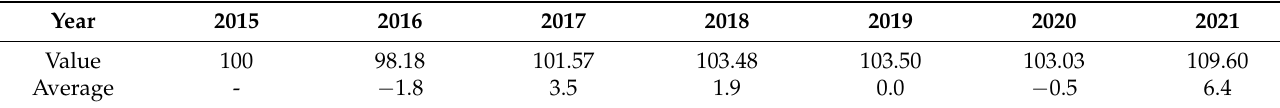
Table 5. Producer price index and average annual inflation in Korea.